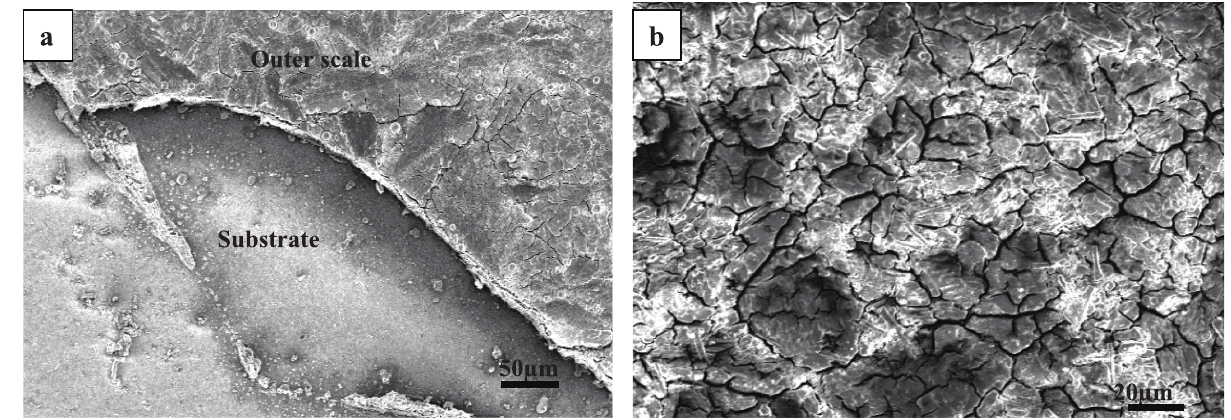
Fig. 5: SEM micrograph of post exposure scale of 50.4% deformed specimen showing (a) scale spallation and (b) scale cracking of the outer scale